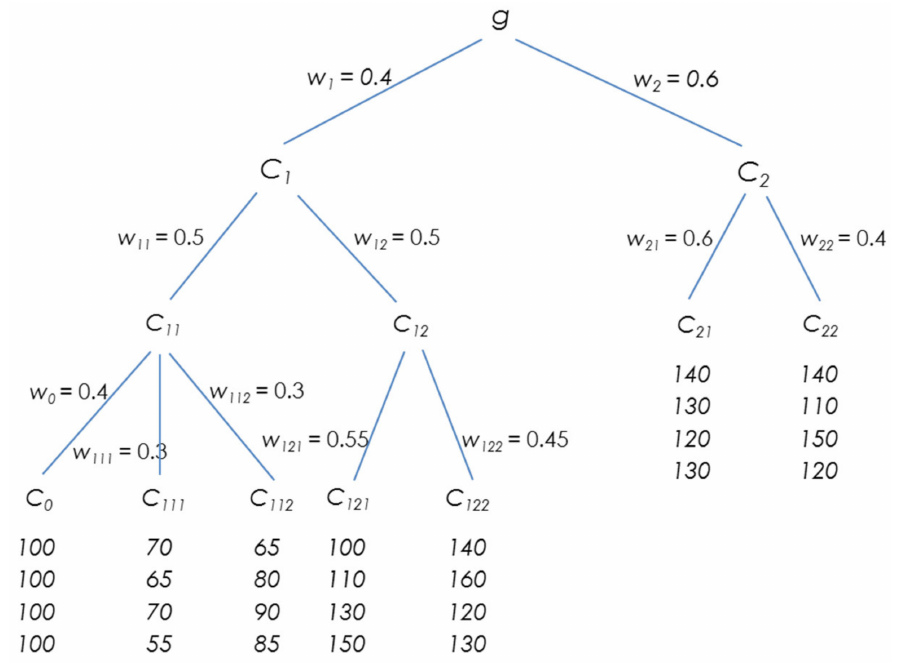
Figure 3. Illustration of Example